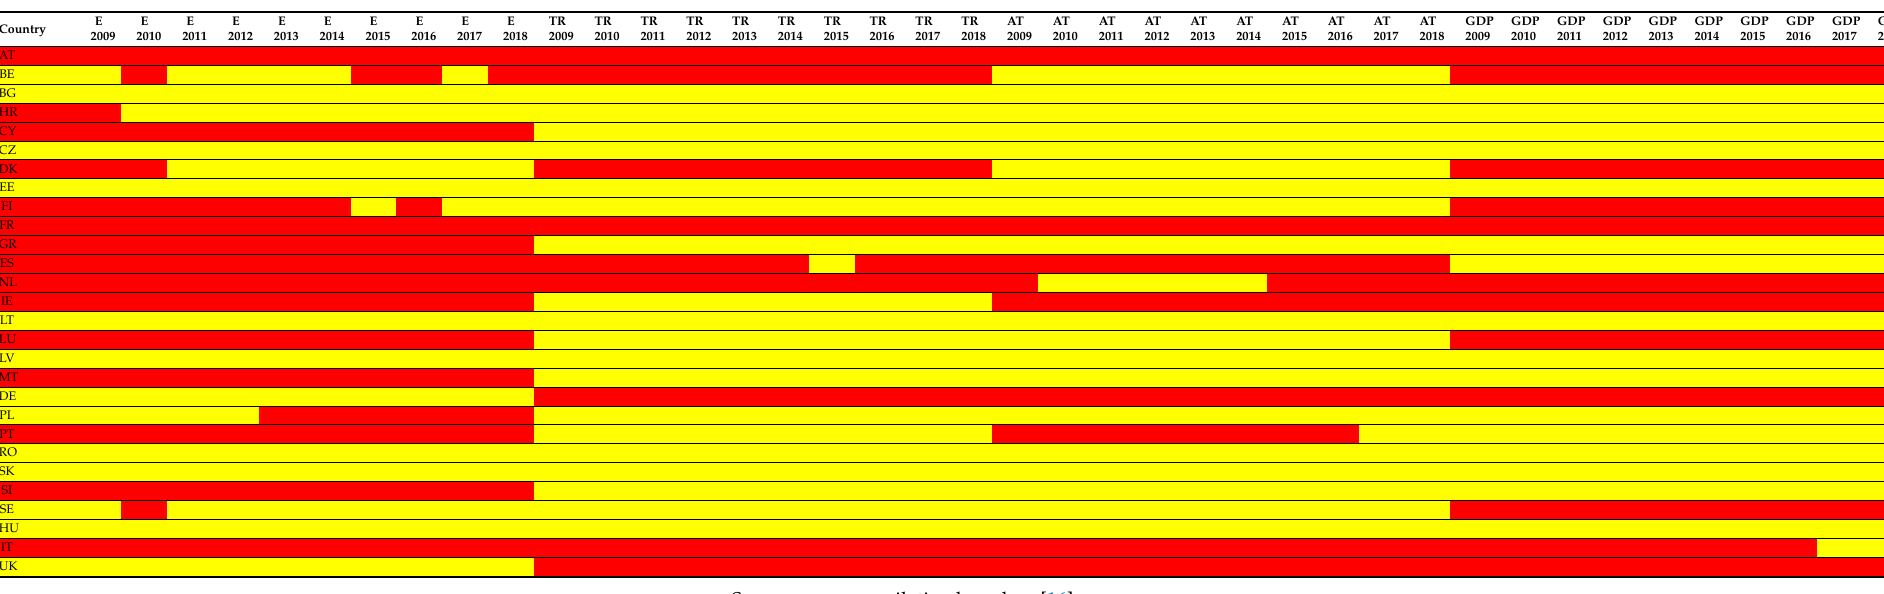
Table A1. The results of the analysis of the relationship between greenhouse gas emissions and air transport, environmental taxes and GDP in the period 2009–2018. Legend: E—Emission,